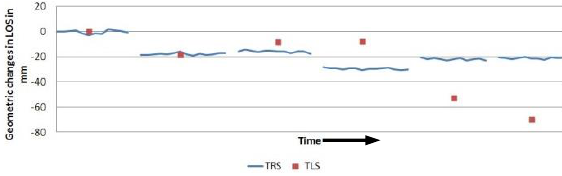
Figure 8: Comparison of TRS (blue) and TLS (red) derived deformations over all epochs in an area